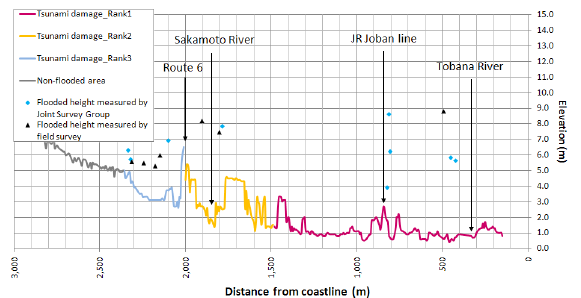
Figure 11. Cross section along EW direction of ground surface Figure 15. Cross section along EW direction of ground surface and tsunami flood depth on profile B (Sendai Airport, Iwanuma and tsunami flood depth on profile F (JR Sakamoto Station, City) Yamamoto